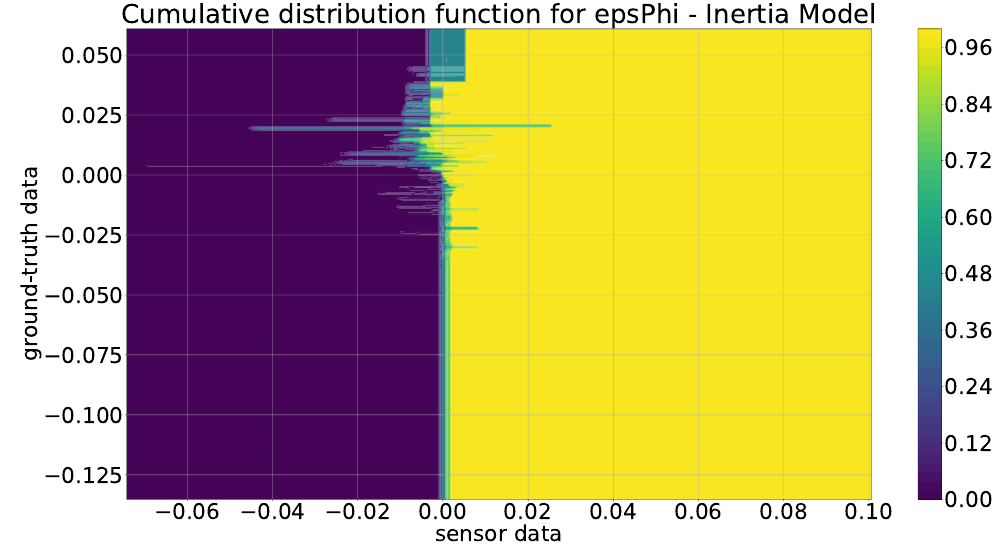
Figure 16. Cumulative distribution function for the inertia model for (cid:101) φ (deg). As described at the end of Section 2.2, the two-dimensional pdf and cdf were evaluated for specific positions in place of the ground-truth values, leading to a one-dimensional pdf and cdf. These one-dimensional pdf and cdf are depicted in Figure 17 for the distance of the inertia model for a value of 0.1 m and in Figure 18 for the angle of the inertia